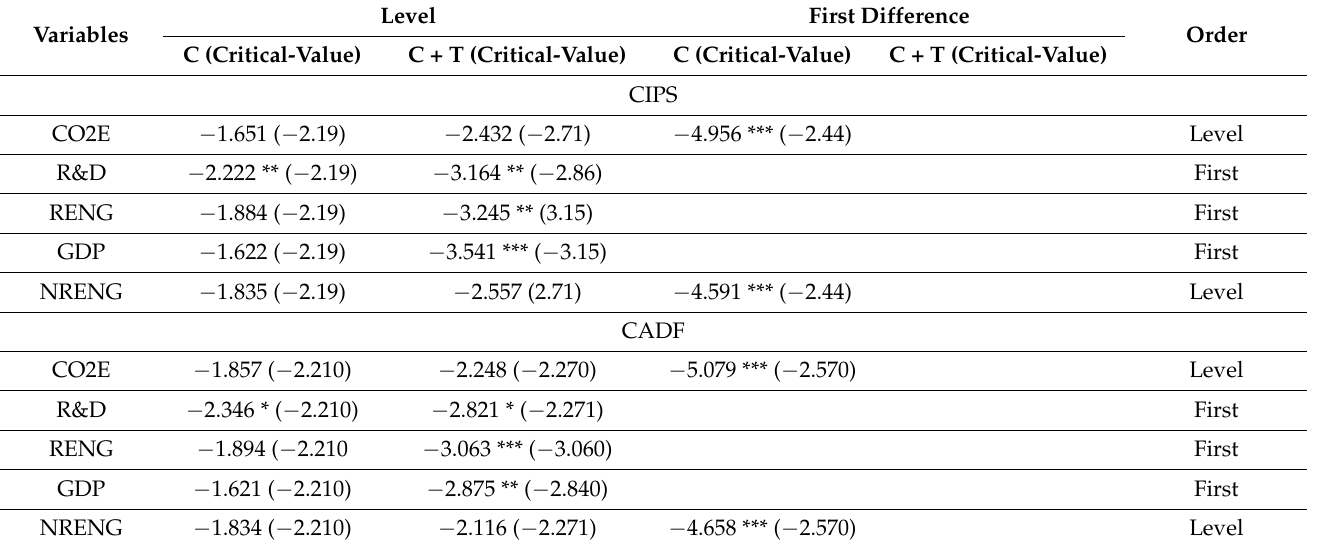
Table 4. CIPS and CADF unit root test.